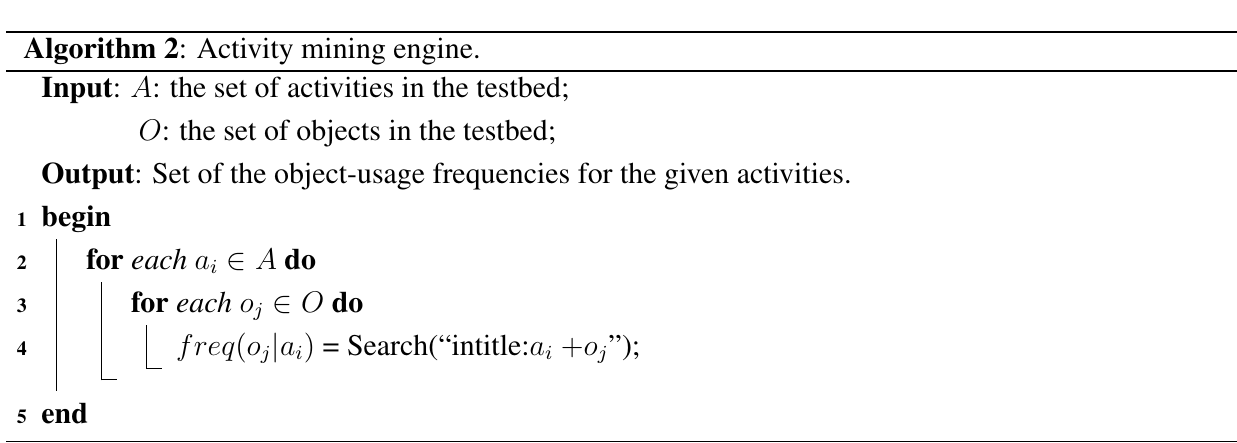
Algorithm 2 : Activity mining engine.